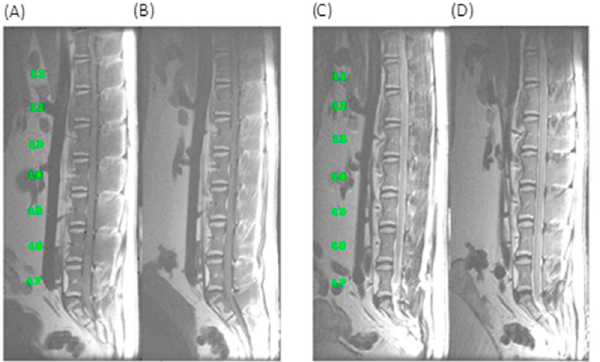
Figure 3. One month MRI scans for sheep USDA#1283. ( A ) T1 weighted baseline ( B ) One month T1 weighted ( C ) T2 weighted FS baseline ( D ) one month T2 weighted FS.